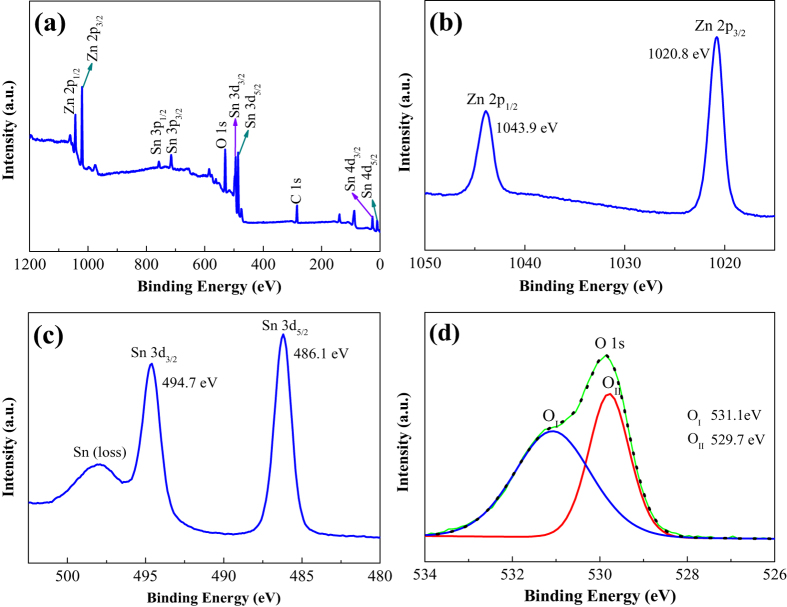
XPS spectra of the as-synthesized SnO2/ZnO heterojunction.(a) XPS full survey spectrum, (b) Zn 2p spectrum, (c) Sn 3d spectrum, (d) O 1s spectrum.